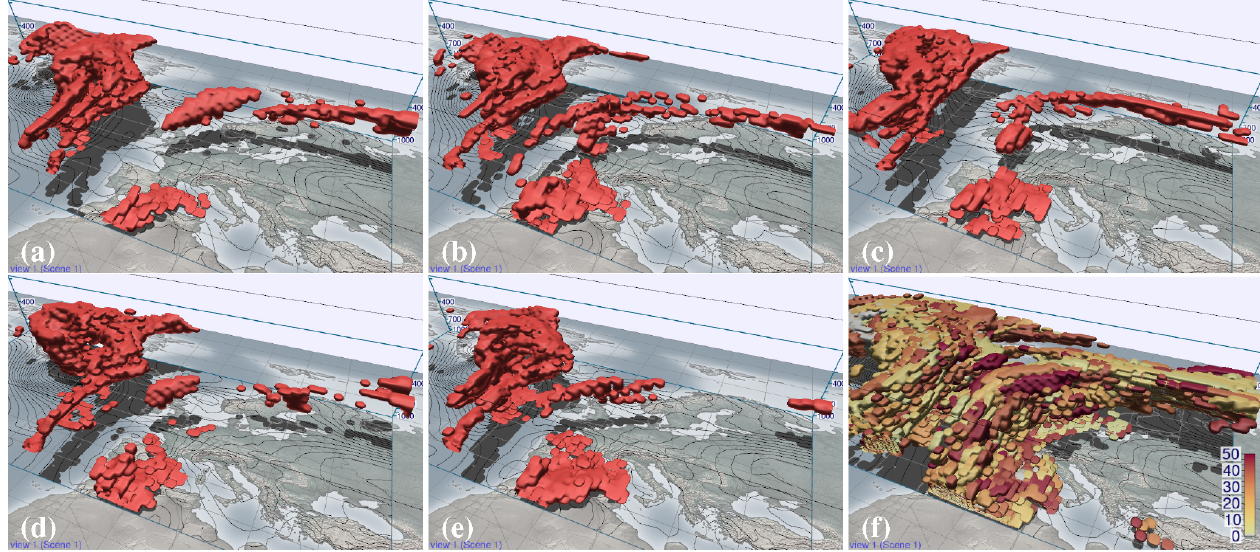
Figure 7. WCB features (binary grids B m ) of further members m of the forecast shown in Fig. 3b. Members (a) 2, (b) 4, (c) 34, (d) 36 and (e) 42. Note that location and shape of the WCB features vary strongly. (f) WCB features of all 51 members of the ensemble, visualized in a single image and distinguished by colour (colour coding denotes member number). Black contour lines in all images show sea level pressure of the corresponding member (of the ensemble mean in f ).